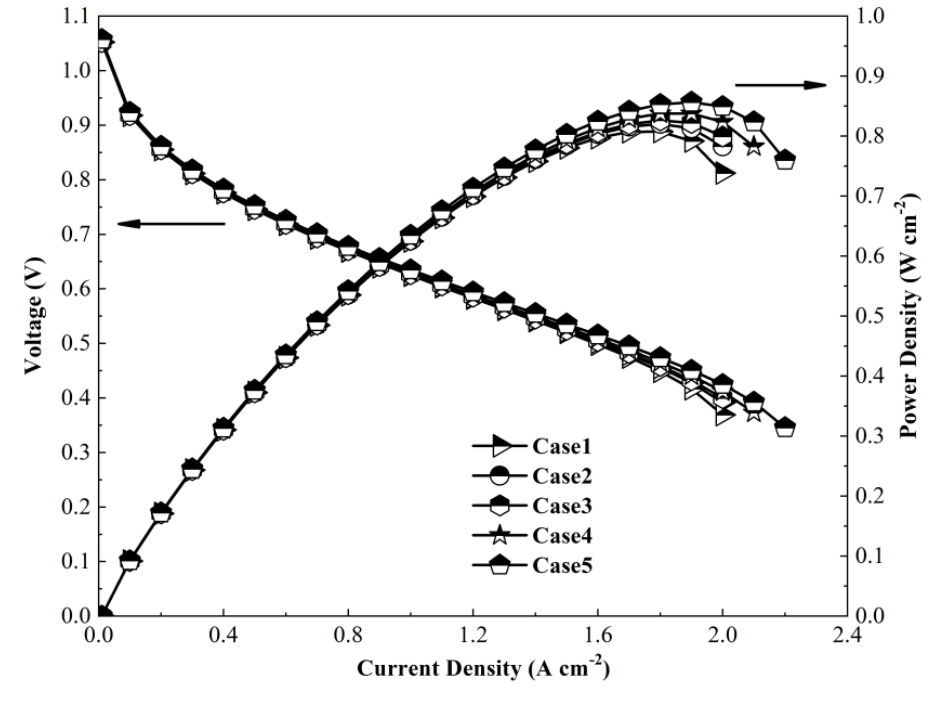
Table 4. Cases under different dimensionless heights of baffles.